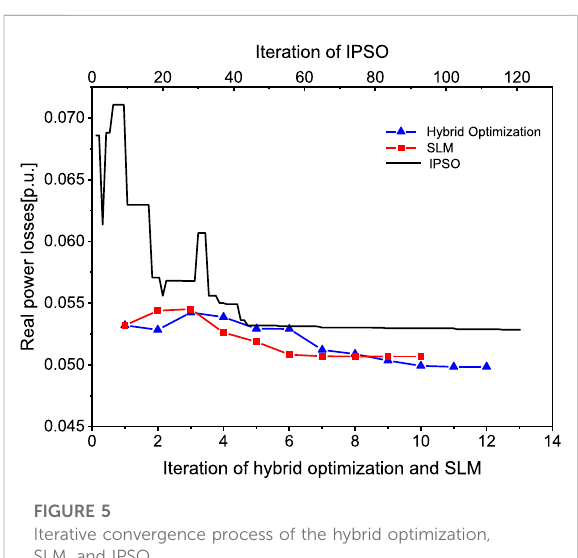
FIGURE 5 Iterative convergence process of the hybrid optimization, SLM, and IPSO.